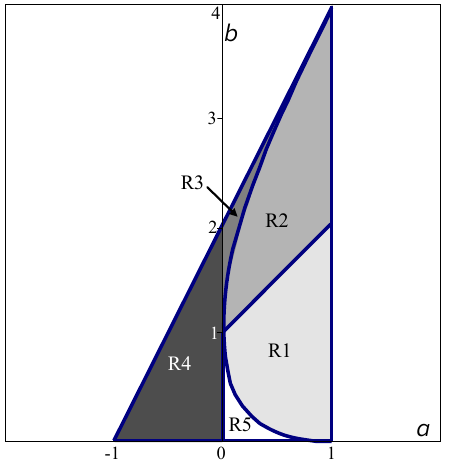
Figure 2. Trelea's deterministic convergence